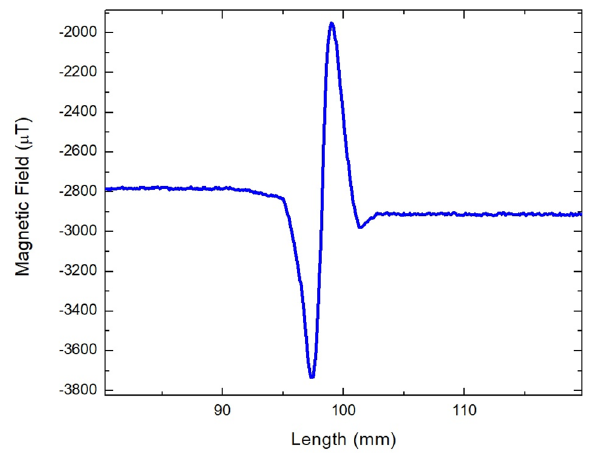
Fig. 18 Experimental result of magnetic field Z of a rectangular defect B1 with ordered magnetic